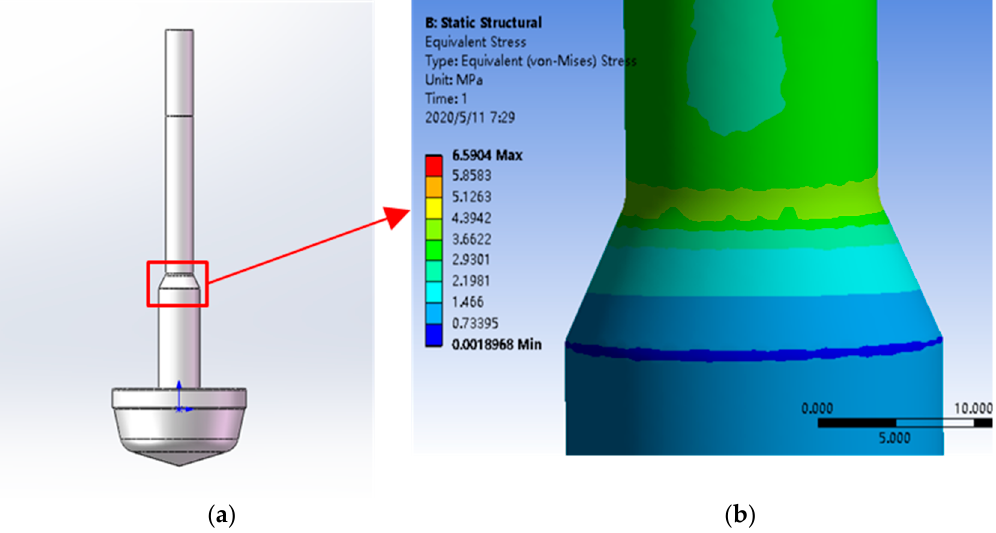
Figure 13. Diagram of improved valve stem structure and of local stresses. ( a ) Improved valve stem structure; ( b ) Local diagram of optimized equivalent stresses.